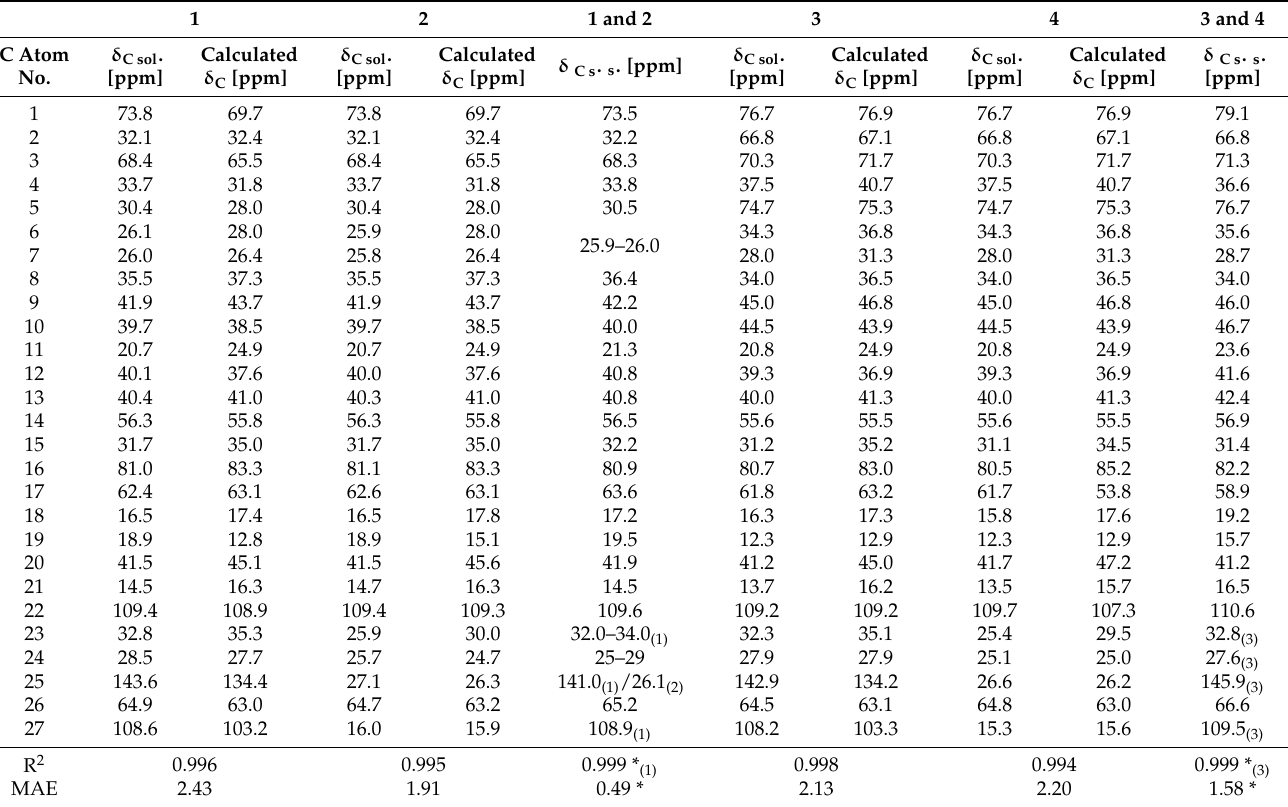
Table 3. 13 C NMR chemical shifts ( δ in ppm) for compounds 1 , 2 (sol: CDCl 3 ; s.s.: solid state) and 3 , 4 , tetrols 1,2,3,5 (sol: CDCl 3 + CD 3 OD (1:1); s.s.: solid state) with calculated chemical shifts ( δ in ppm) Verification parameters at the bottom of the table: correlation coefficients R 2 and mean absolute errors